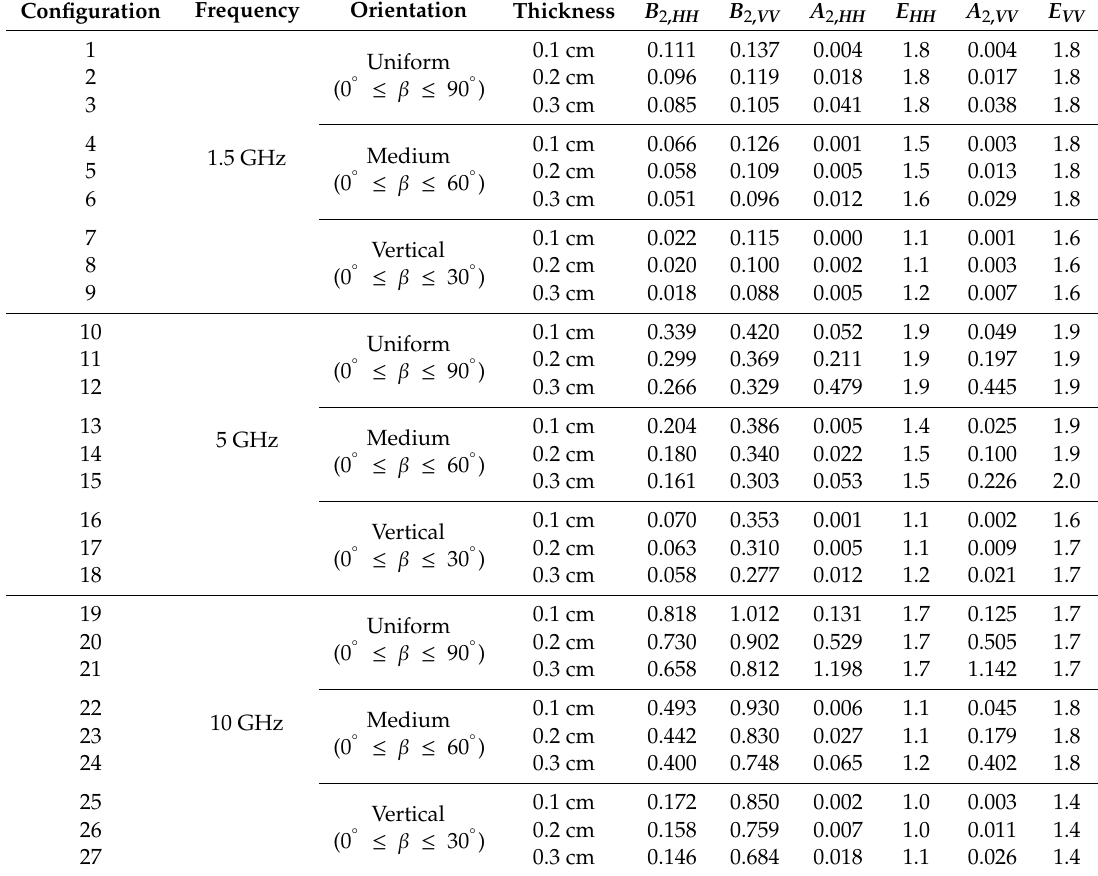
Table 2. Di ff erent simulation configurations for the GRG-based physical model simulations and results of the WCM parameter